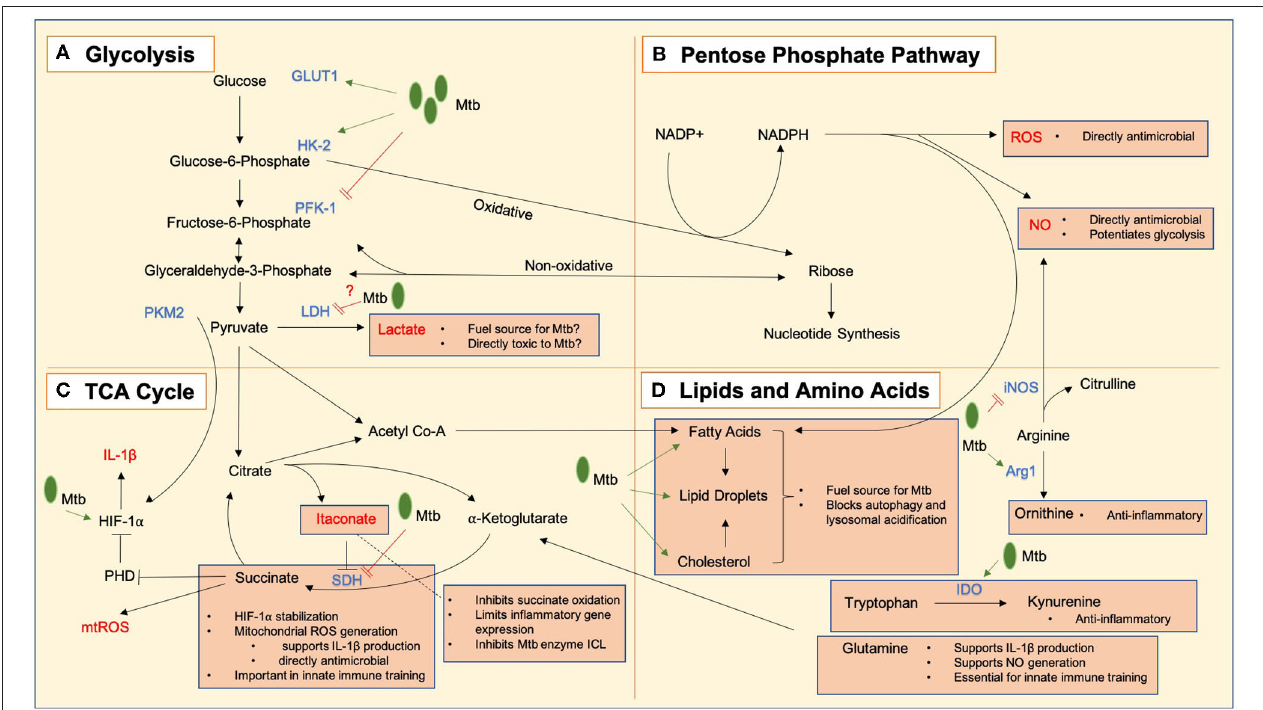
FIGURE 1 | Key metabolic pathways and metabolic intermediates in Mtb immune responses. Mycobacterium tuberculosis bacilli are notated as Mtb in green, and : processes upregulated and downregulated by infection indicated using green arrows ( ) and red lines ( = ) respectively. (A) Glycolysis converts glucose to lactate which may act as both a fuel source for Mtb and have direct antimicrobial effects. GLUT1, the glucose transporter, is upregulated in response to Mtb infection, and hexokinase 2 (HK2) is also upregulated to allow an enhanced glycolytic rate. Mtb may limit the induction of glycolysis by negative regulation of the rate-limiting enzyme phosphofructokinase 1 (PFK-1). Lactate dehydrogenase (LDH) is upregulated in infected macrophages, allowing enhanced conversion of pyruvate to lactate, which may act as an alternative fuel source for Mtb or a directly toxic antimicrobial mediator. There is evidence that Mtb negatively regulates this process. Pyruvate kinase M2 (PKM2) works in tandem with hypoxia inducible factor 1 alpha (HIF-1 α ) to allow transcription of IL-1 β . (B) The pentose phosphate pathway produces NADPH which is used to generate reactive oxygen species (ROS) and nitric oxide (NO) which are directly antimicrobial, and NO has additional roles in the potentiation